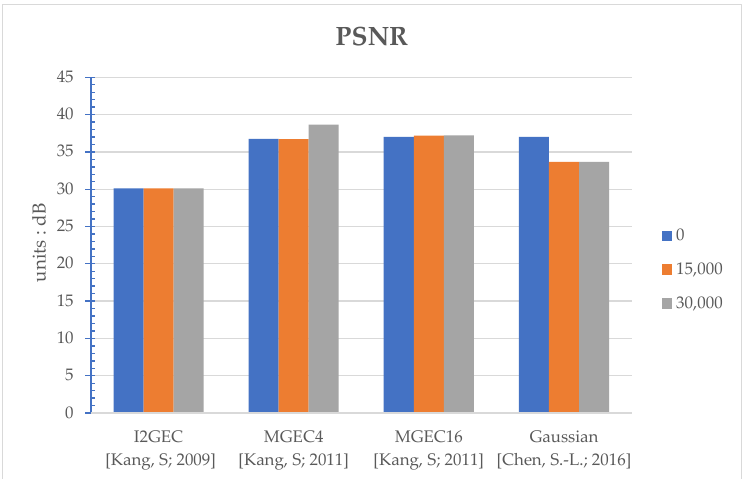
Figure 4. Bar comparisons of PSNR (dB) of different algorithms at different thresholds [9,10,13]. Sensors 2022 , 22 , x FOR PEER REVIEW